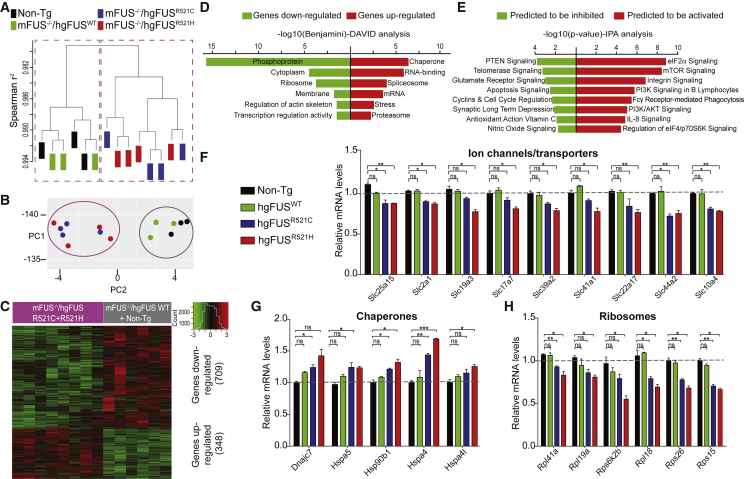
ALS-Linked Mutations in FUS Cause a Mutant-Dependent Signature of RNAs that Includes a Reduction in mRNAs for Ion Channels and Transporters and Ribosomal Proteins and an Increase in mRNAs Encoding Chaperones(A) Unsupervised hierarchical clustering of all expressed genes in spinal cords of 18-month-old Non-Tg, mFus−/−/hgFUSWT, mFus−/−/hgFUSR521C, and mFus−/−/hgFUSR521H mice identified by RNA-seq analysis.(B) Principal component analysis (PCA) of differentially expressed genes in 18-month-old Non-Tg, mFus−/−/hgFUSWT, mFus−/−/hgFUSR521C, and mFus−/−/hgFUSR521H spinal cords.(C) Heatmap with hierarchical clustering of 1,057 genes differentially expressed in 18-month-old hgFUSR521C and hgFUSR521H mice compared to age-matched Non-Tg and mFus−/−/hgFUSWT spinal cords.(D) Functional analysis using DAVID software of the differentially expressed genes revealing the most enriched gene group changes in mFus−/−/hgFUSR521C and mFus−/−/hgFUSR521H mice compared to age-matched Non-Tg and mFus−/−/hgFUSWT animals.(E) Functional analysis using the Ingenuity Pathway Analysis (IPA) software of the differentially expressed genes revealing the most enriched gene group changes in mFus−/−/hgFUSR521C and mFus−/−/hgFUSR521H mice compared to age-matched Non-Tg and mFus−/−/hgFUSWT animals.(F) Reduced expression of ion channels and transporters essential for synaptic function in 18-month-old mFus−/−/hgFUSR521C and mFus−/−/hgFUSR521H spinal cords compared to age-matched Non-Tg and mFus−/−/hgFUSWT, validated by qRT-PCR. Data are represented as mean ± SEM (n ≥ 3 per group). ∗p < 0.05, ∗∗p < 0.01, two-sided unpaired Student’s t test. See also Figure S5A.(G) Increased expression of chaperones in 18-month-old mFus−/−/hgFUSR521C and mFus−/−/hgFUSR521H spinal cords compared to age-matched Non-Tg and mFus−/−/hgFUSWT, validated by qRT-PCR. Data are represented as mean ± SEM (n ≥ 3 per group). ∗p < 0.05, ∗∗p < 0.01 and ∗∗p < 0.001, two-sided unpaired Student’s t test. See also Figure S5B.(H) Reduced expression of genes encoding ribosomes or other components of the translation machinery in 18-month-old mFus−/−/hgFUSR521C and mFus−/−/hgFUSR521H spinal cords compared to age-matched Non-Tg and mFus−/−/hgFUSWT, validated by qRT-PCR. Data are represented as mean ± SEM (n ≥ 3 per group). ∗p < 0.05 and ∗∗p < 0.01, two-sided unpaired Student’s t test. See also Figure S5C.